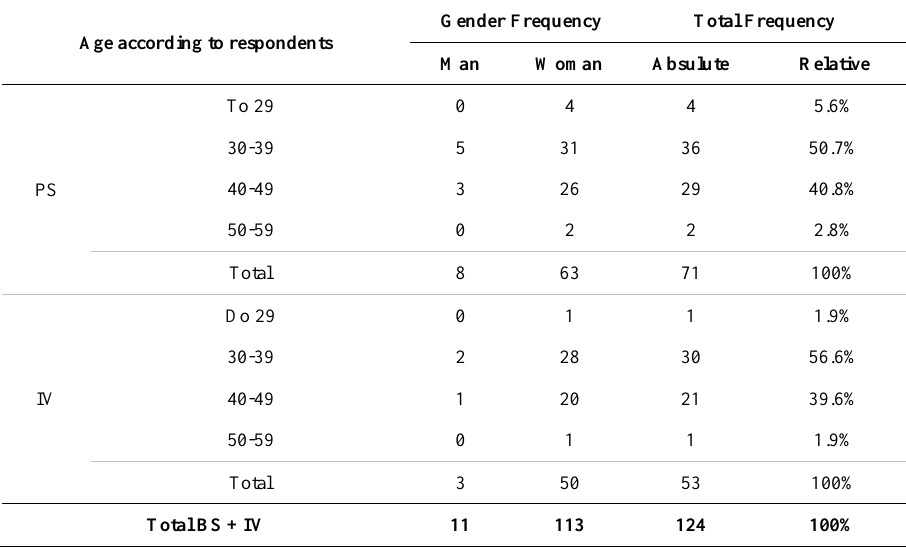
Table 1. Distribution of age and gender of respondents (parents).